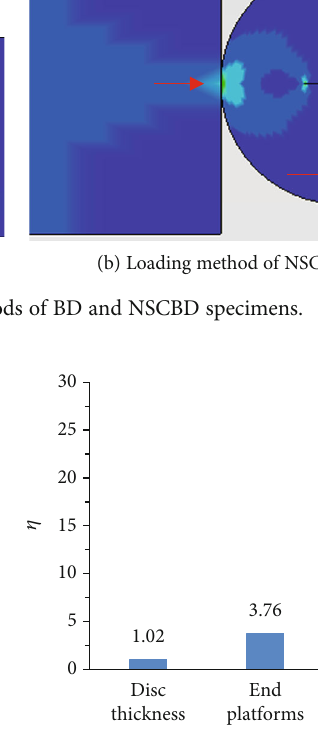
Figure 22: In fl uence factors of four